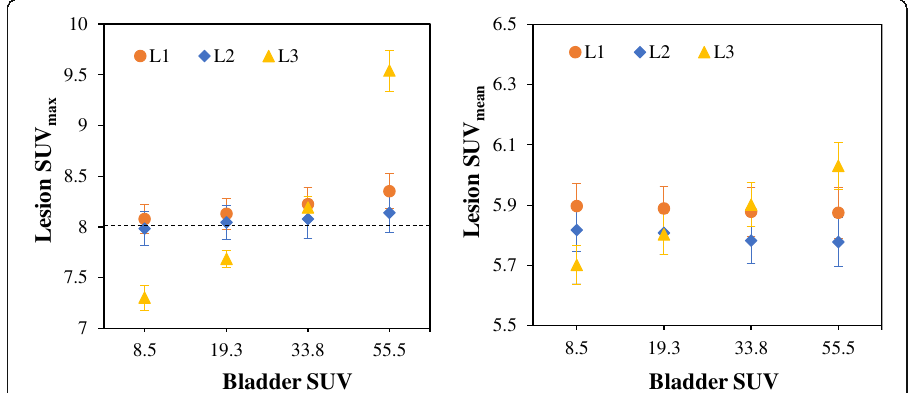
Fig. 4 The lesion uptake as the bladder SUV increases for images reconstructed with OSEM. These are the mean SUVs from all the 20 noise realisations and for lesion diameter 10 mm at 30 full iterations. The error bars are the standard error of the mean (SEM) while the dashed horizontal line denotes the true simulated lesion